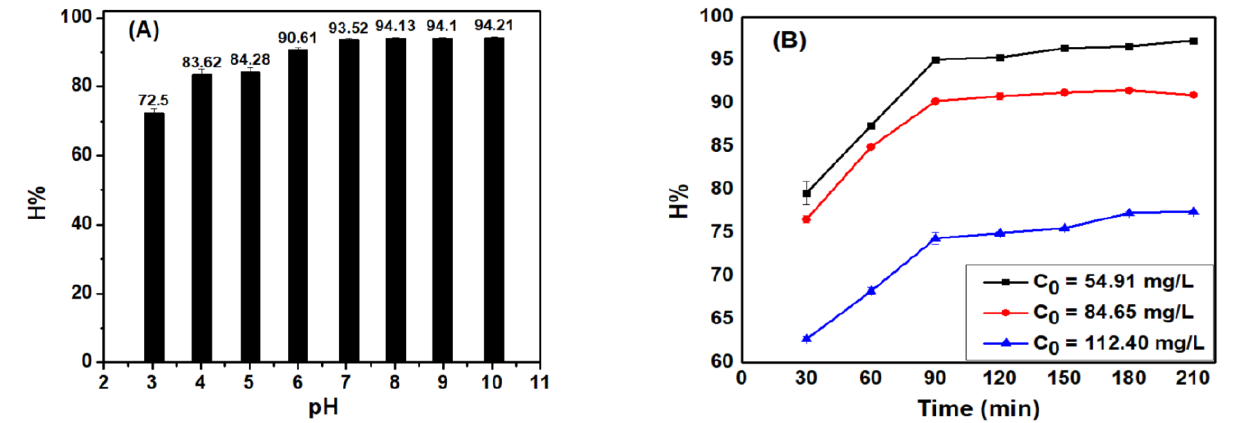
Figure 6. The effect of ( A ) pH and ( B ) reaction time on the efficiency of MB adsorption process of ACDS.